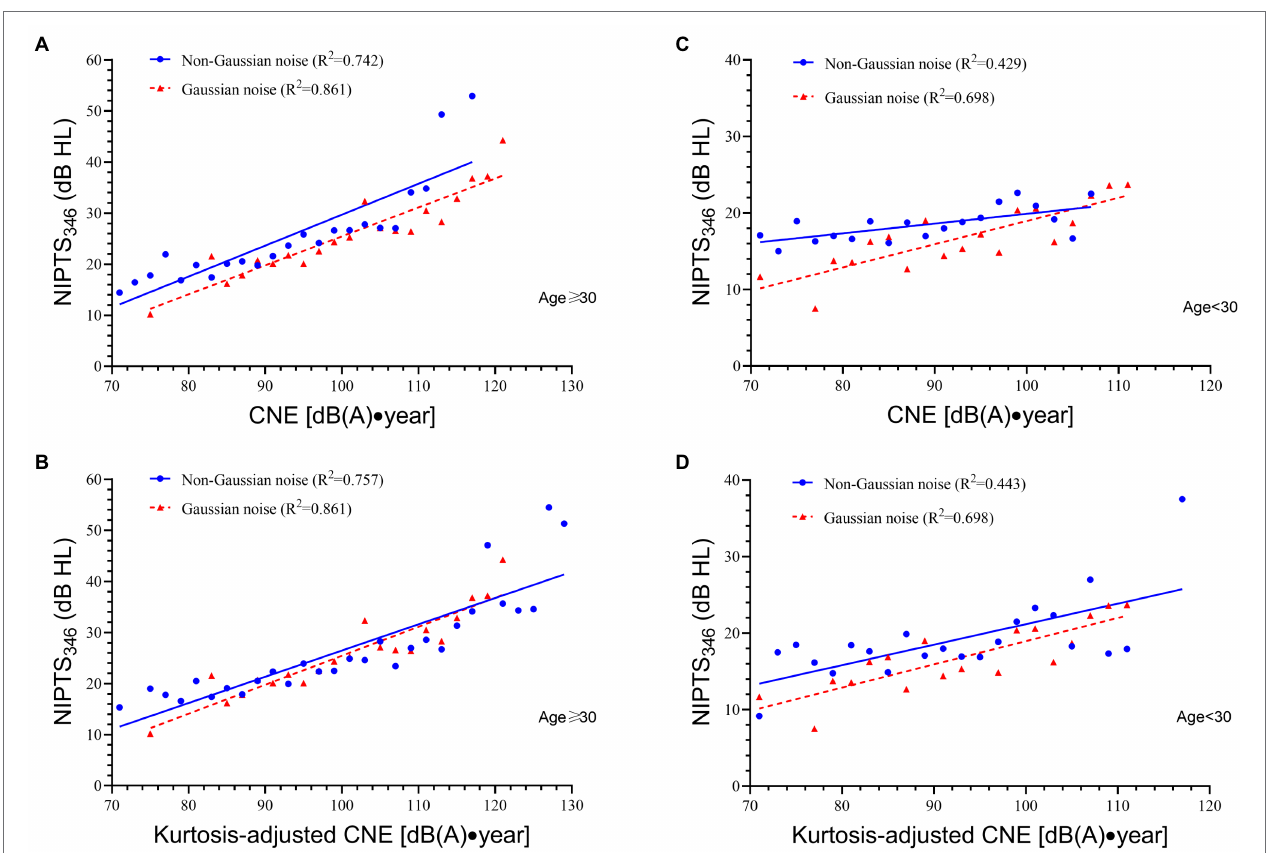
FIGURE 3 | The linear relationship between NIPTS 346 and CNE or CNE ′ for workers aged ≥ 30 and aged <30. (A) The linear relationship between NIPTS 346 and CNE for workers aged ≥ 30. The regression equation for Gaussian noise is NIPTS 346 = 0.567CNE—31.269, R 2 = 0.861. The regression equation for non-Gaussian noise is NIPTS 346 = 0.606CNE ′ —30.916, R 2 = 0.742. (B) The linear relationship between NIPTS 346 and CNE ′ for workers aged ≥ 30. The regression equation for non-Gaussian noise is NIPTS 346 = 0.514CNE ′ —24.925, R 2 = 0.757. (C) The linear relationship between NIPTS 346 and CNE for workers aged <30. The regression equation for Gaussian noise is NIPTS 346 = 0.304CNE—11.397, R 2 = 0.698. The regression equation for non-Gaussian noise is NIPTS 346 = 0.128CNE ′ —7.132, R 2 = 0.429. (D) The linear relationship between NIPTS 346 and CNE ′ for workers aged <30. The regression equation for non-Gaussian noise is NIPTS 346 = 0.268CNE ′ —5.640, R 2 =